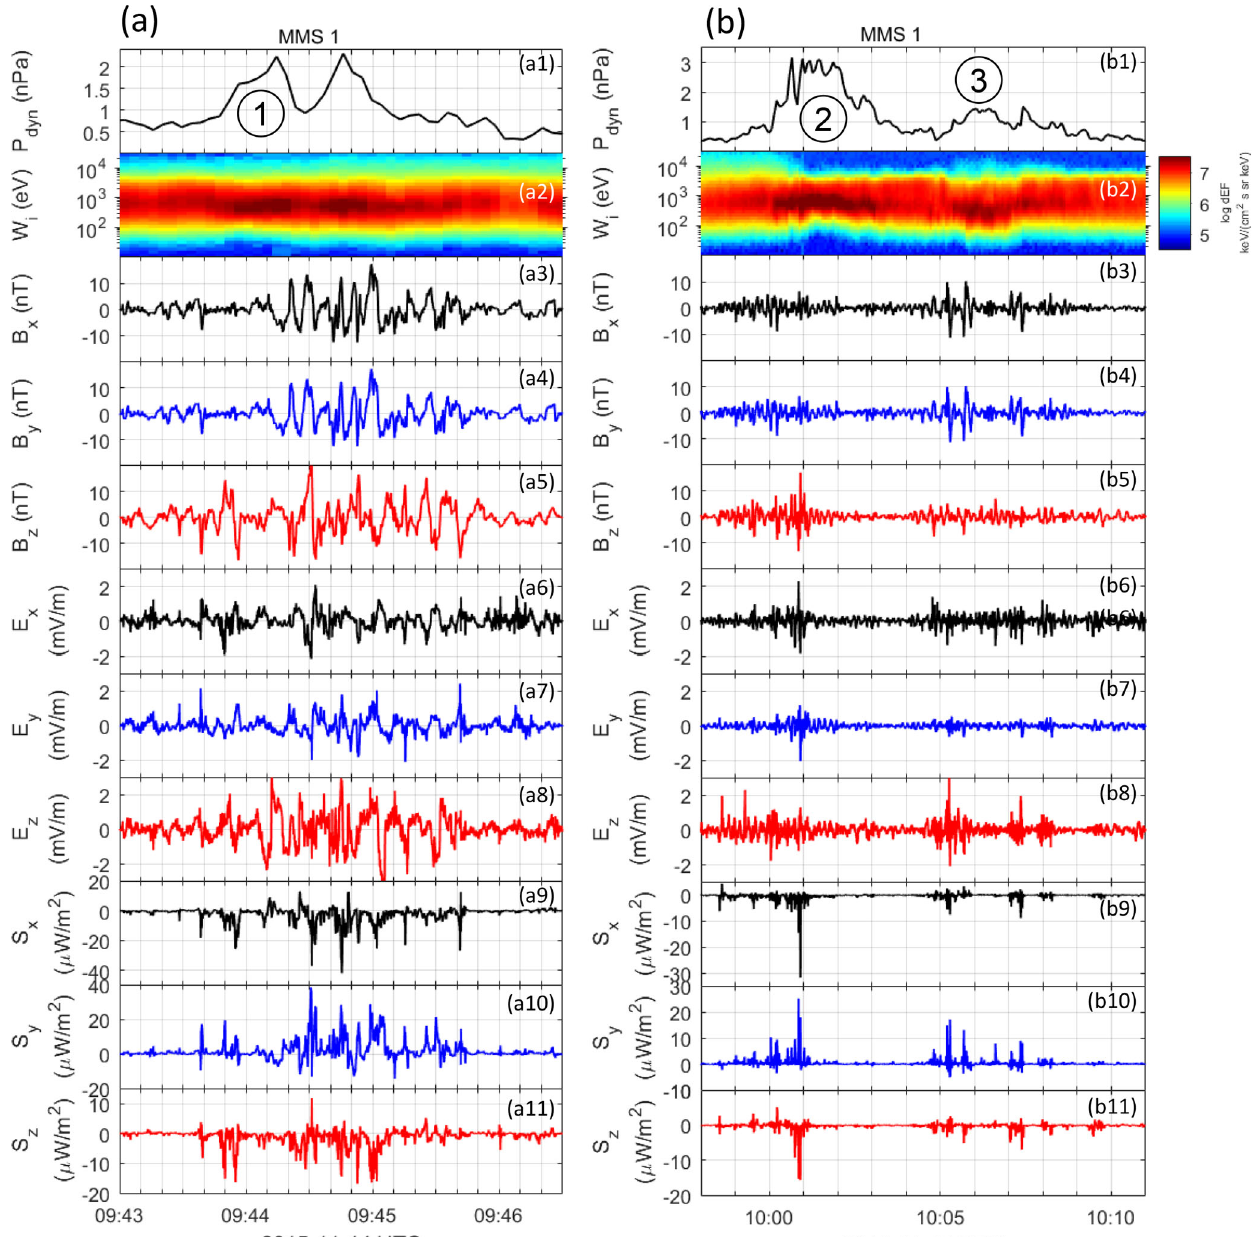
Figure 8. Detailed view of low-frequency wave activity for jets no. 1 (a) and jets no. 2 and 3 (b) . From top to bottom: dynamic pressure, ion spectrogram, electric and magnetic fields with the DC component removed as in Fig. 7, and components of the Poynting flux ( S ), calculated from the low-frequency electric and magnetic field shown in sub-panels (a3)–(a8) and (b3)–(b8),